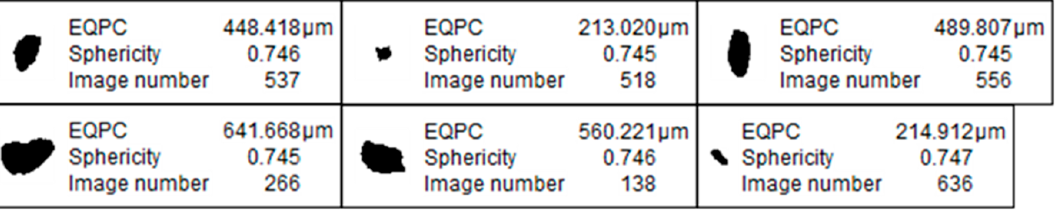
Figure 3. Some images of silica particles (Sympatec-Qicpic). Table 1. Size and shape properties of the silica particles.